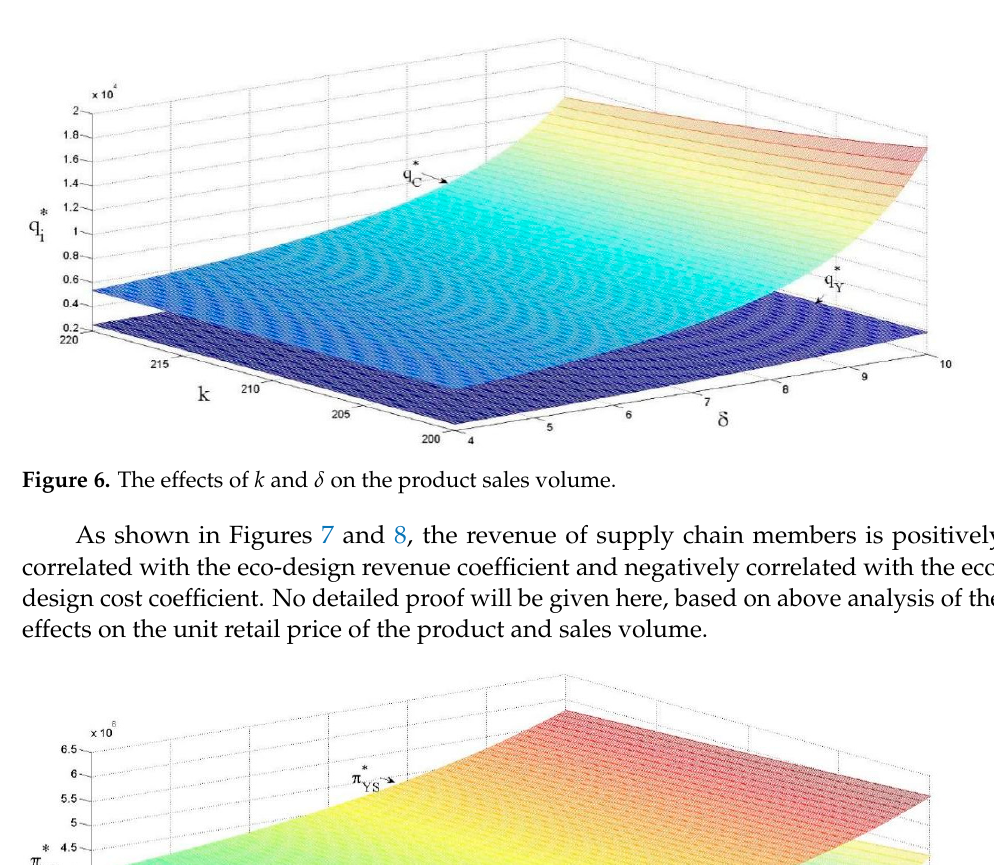
Figure 6 . The effects of k and